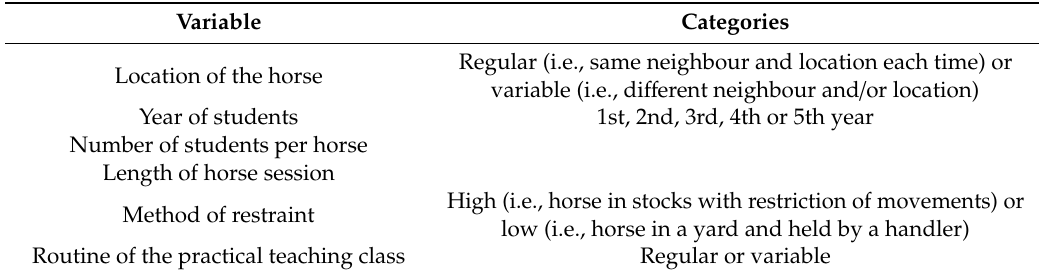
Table 1. Variables chosen to describe the practical teaching